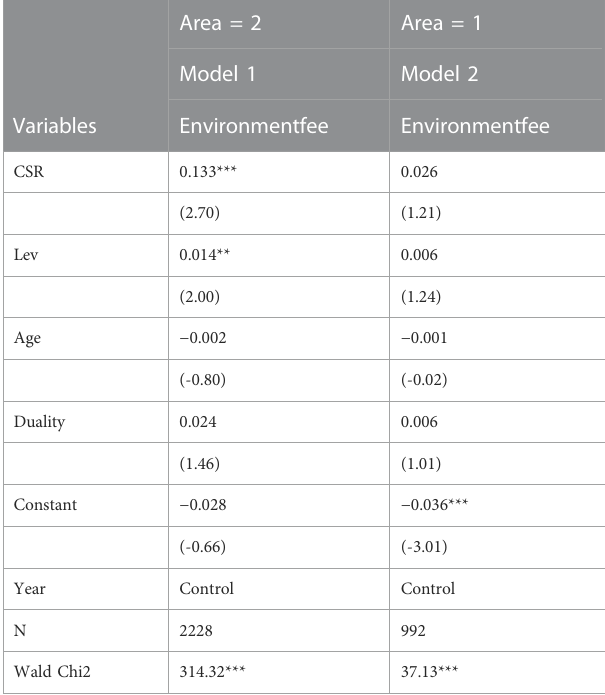
TABLE 6 Further analysis of fi rms in different